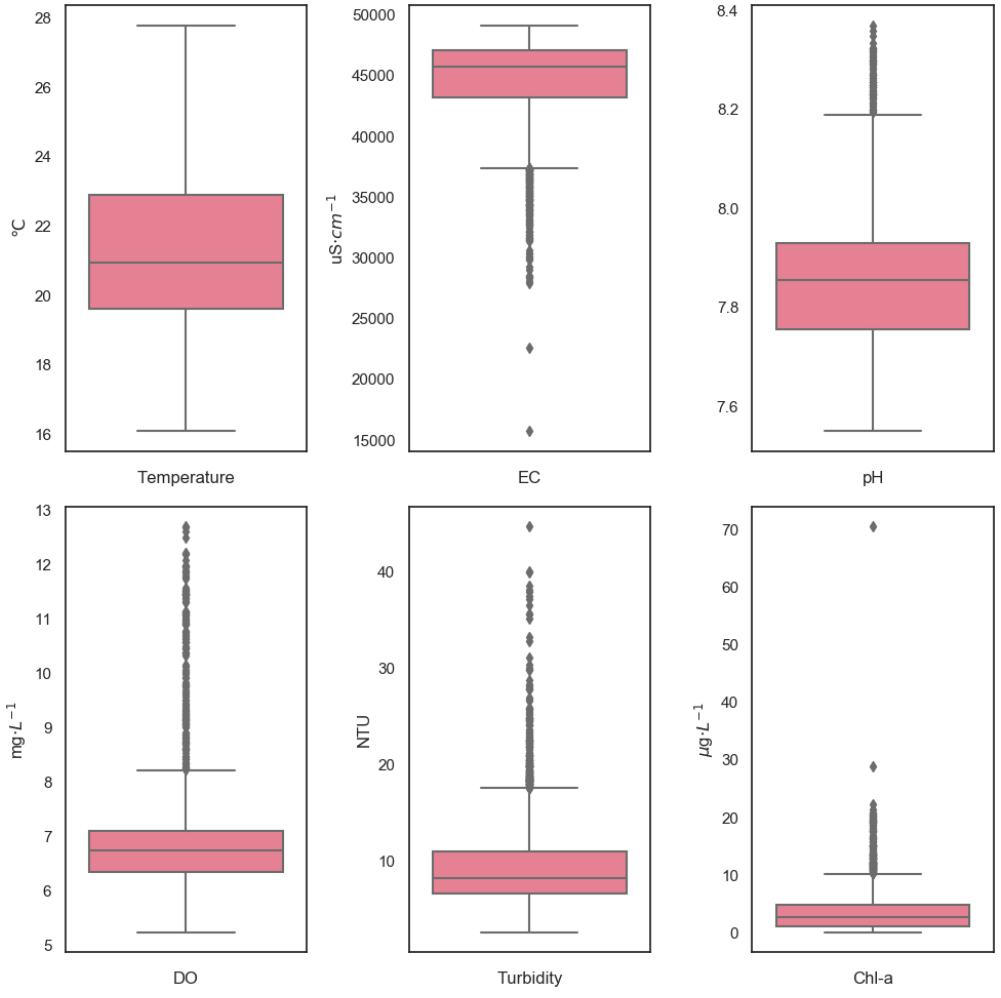
Figure 2. Data distribution for six water quality